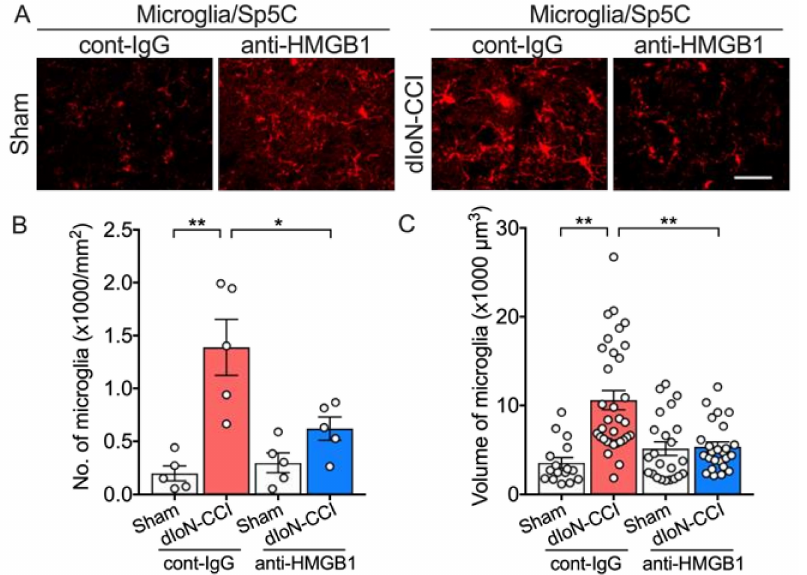
Figure 7. Effect of anti-HMGB1 nAb treatment on microglia in Sp5C in sham and dIoN-CCI mice. ( A ) Fluorescent photomicrographs of Iba1 in Sp5C from sham and dIoN-CCI mice 14 days following surgery. ( B ) density (number of cells/mm 2 ) of n = 5 mice and ( C ) mean cell volume ( n = 17–33 cells from 3 consecutive ipsilateral sections) 14 days following surgery. Scale bar = 50 µ m. Data are expressed as individual and mean ± SEM. * p < 0.05, ** p < 0.01 (two-way ANOVA followed by Sidak’s correction for multiple